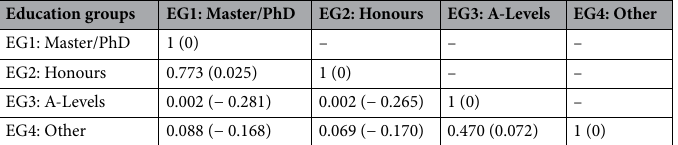
Table 6. p-values and effect size η groups.